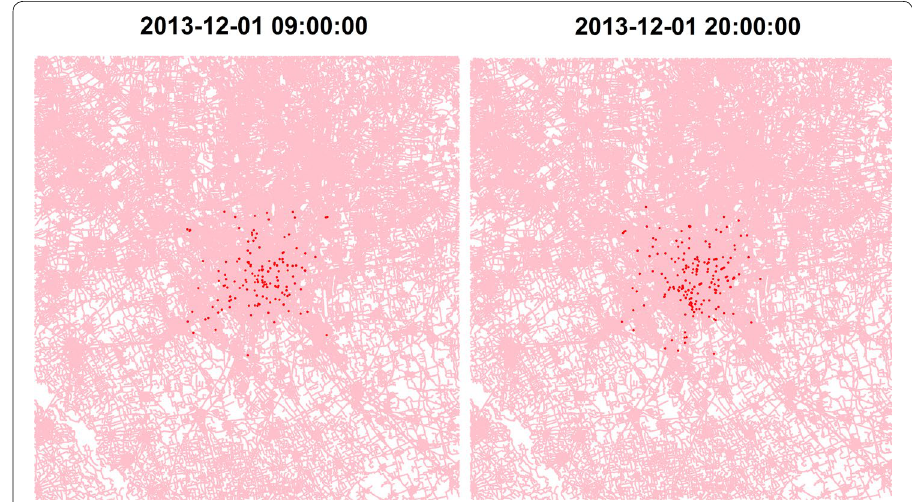
Fig. 15 Location of every tweets in Milan city at 9 a.m. and 8 p.m. at 12/01/2013 display at the real map. The pink lines are the read road network. The red dots are the location of twitter users